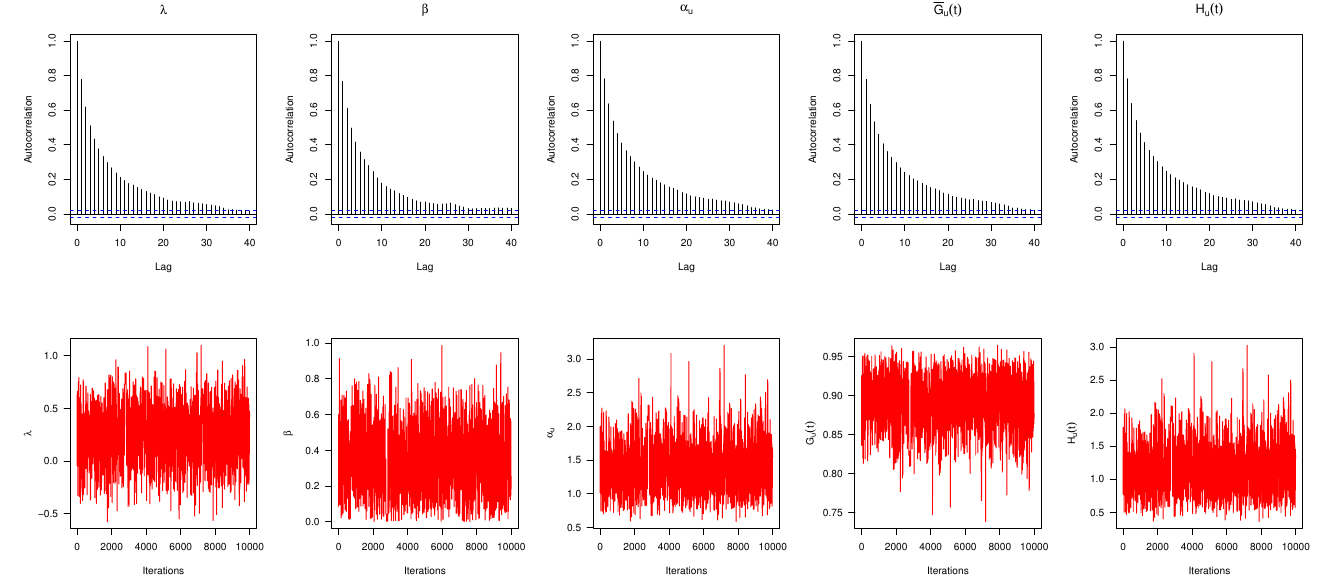
Figure 1. Autocorrelation ( top ) and trace ( bottom ) plots for MCMC draws in Monte Carlo simulation. Now, the comparison between the acquired point estimates of λ is made based on their root mean squared errors (RMSEs) and mean absolute biases (RABs), respectively, as RMSE =